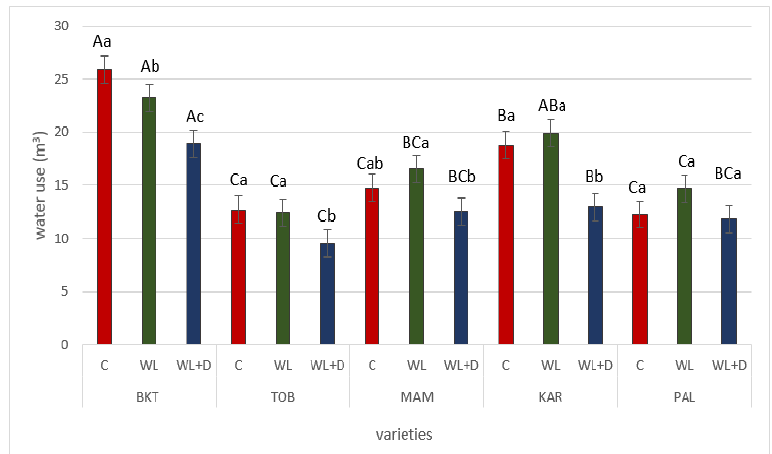
Figure 5. Water-use values of ‘Bánkúti 1201’ (BKT), ‘Mv Toborzó’ (TOB), ‘Mv Mambó’ (MAM), ‘Mv Karizma’ (KAR) and ‘Mv Pálma’ (PAL) varieties in the different treatments. ‘C’: control treatment; ‘WL’: waterlogging treatment; ‘WL + D’: combined treatment of waterlogging and drought. Capital letters indicate the statistical significance between the varieties at p ≤ 0.05 level; lowercase letters indicate the statistical significance between the treatments at p ≤ 0.05. Error bars represent honestly significant difference (HSD) 5% values (n = 3).